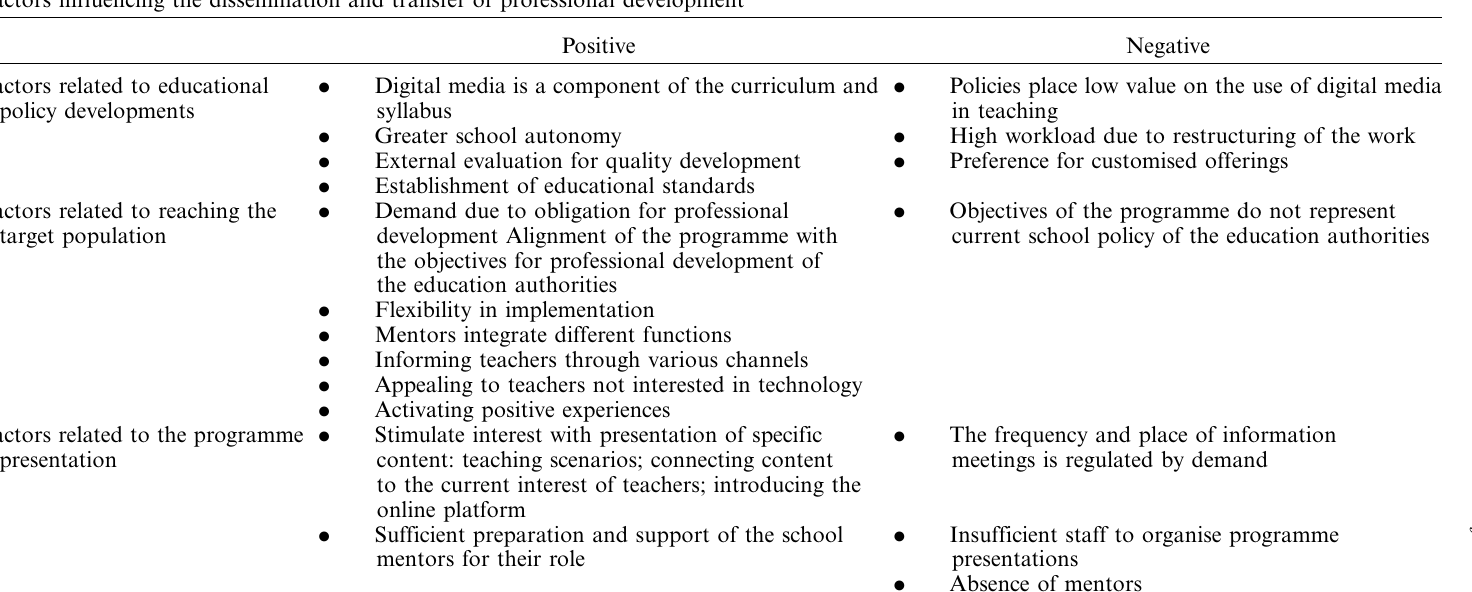
Table 1. Factors with positive and negative effect on the dissemination and transfer of the professional development programme Intel Teach (cid:1) Advanced Online in Germany. Factors influencing the dissemination and transfer of professional